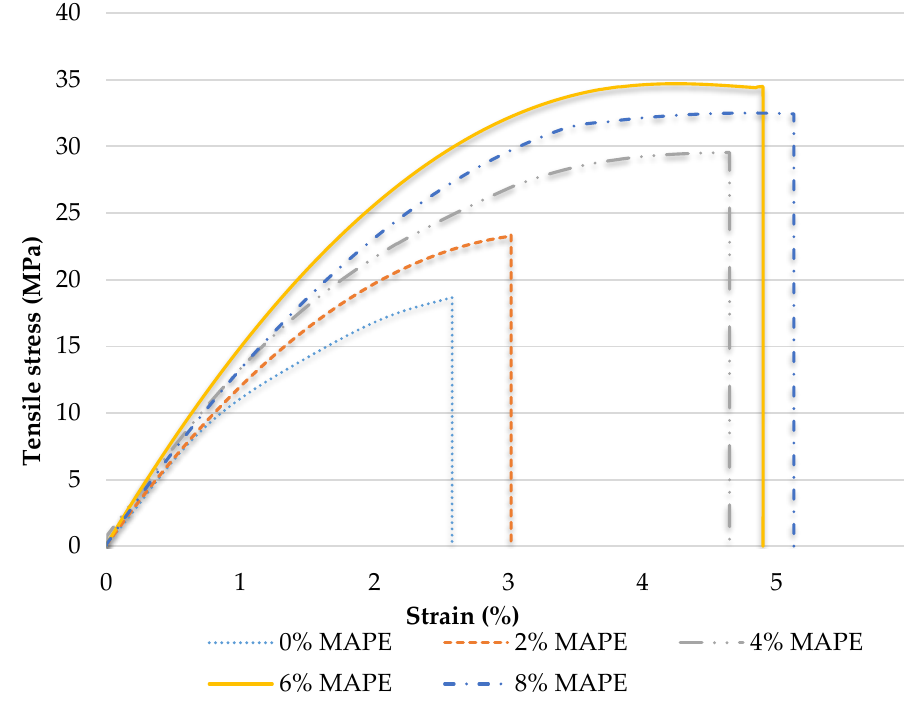
Figure 5. Stress-Strain curves for the 30 wt.% CSF reinforced BioPE composites at 0 to 8 wt.% MAPE contents.